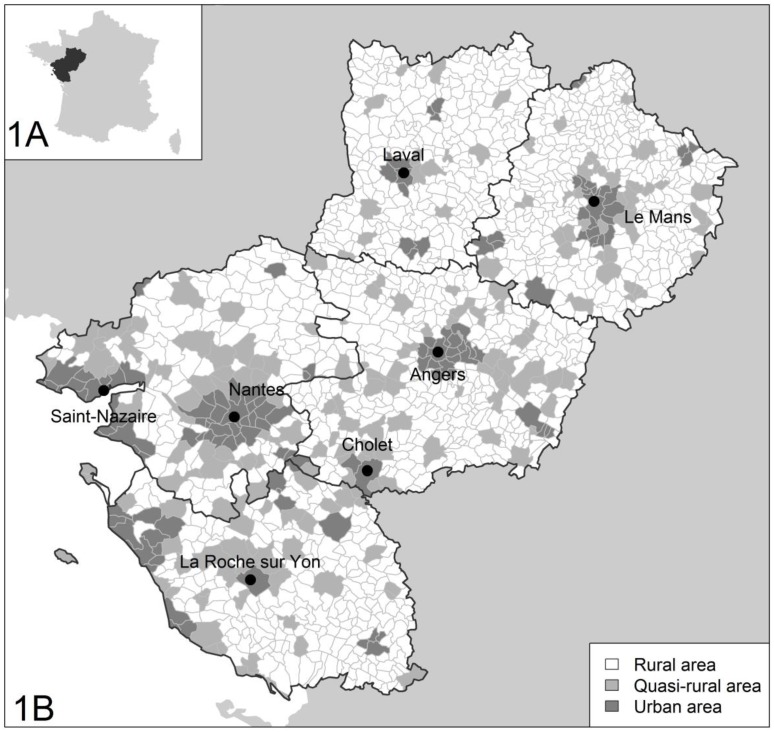
A) Localization of the PDL region in France B) Urbanicity and major cities in the PDL region.